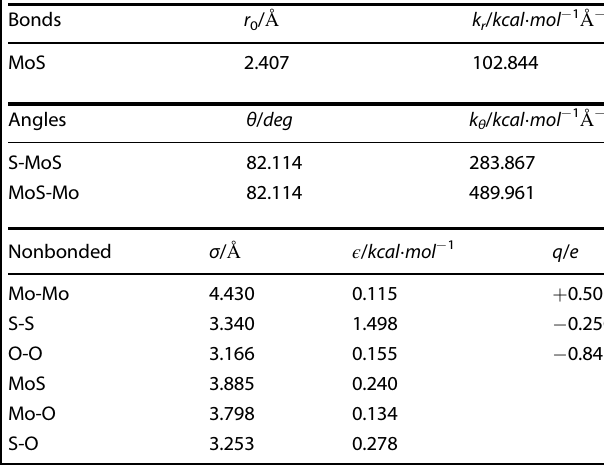
Table 1. The force- fi eld parameters adopted in the molecular dynamic